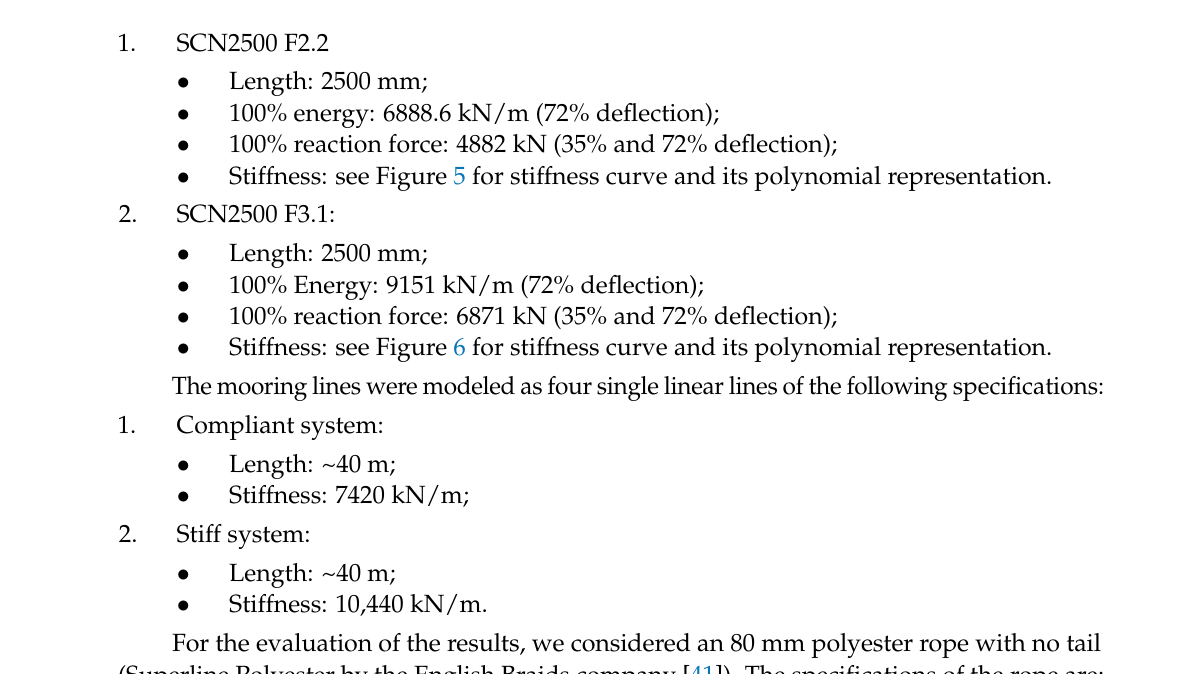
Stiffness: see Figure 5 for stiffness curve and its polynomial representation.